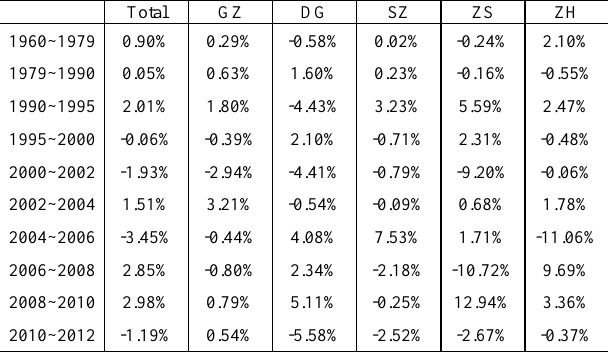
Table 2. The average annual change of coastline